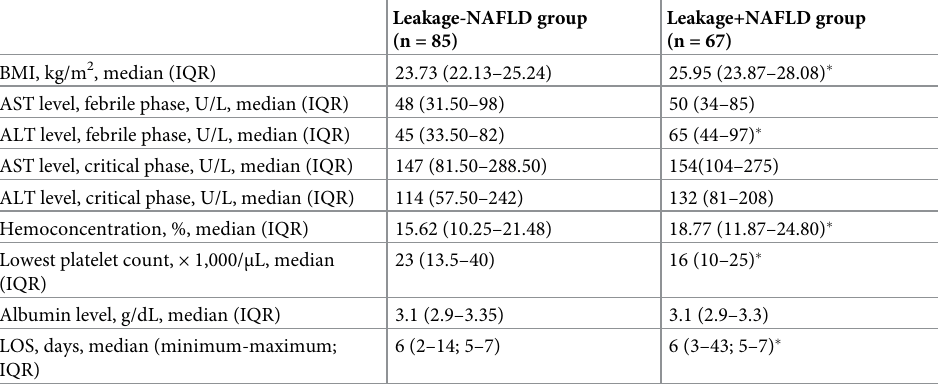
Abbreviations: NAFLD, nonalcoholic fatty liver disease; BMI, body mass index; AST, aspartate aminotransferase; ALT, alanine aminotransferase; IQR, interquartile range; LOS, length of hospital